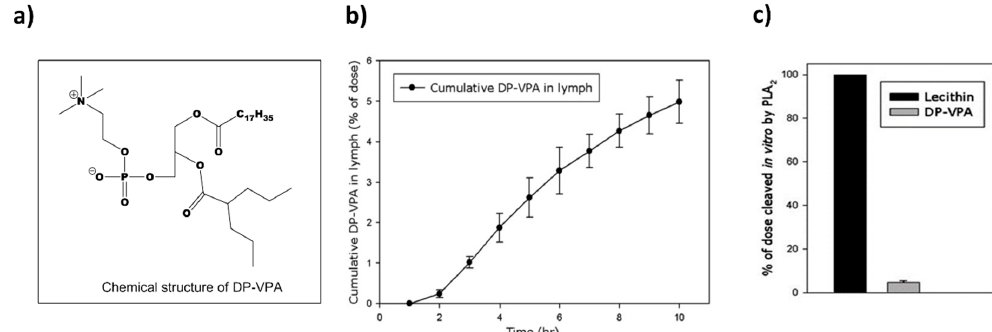
Figure 2. ( a ) structure of valproic acid prodrug (DP-VPA); ( b ) % of DP-VPA dose recovered in the rat lymph following oral DP-VPA dose (100 mg/kg) in LCT formulation; ( c ) PLA 2 -mediated activation of DP-VPA vs. phosphatidylcholine in-vitro . Reproduced with permission from reference [28], Elsevier, 2008.